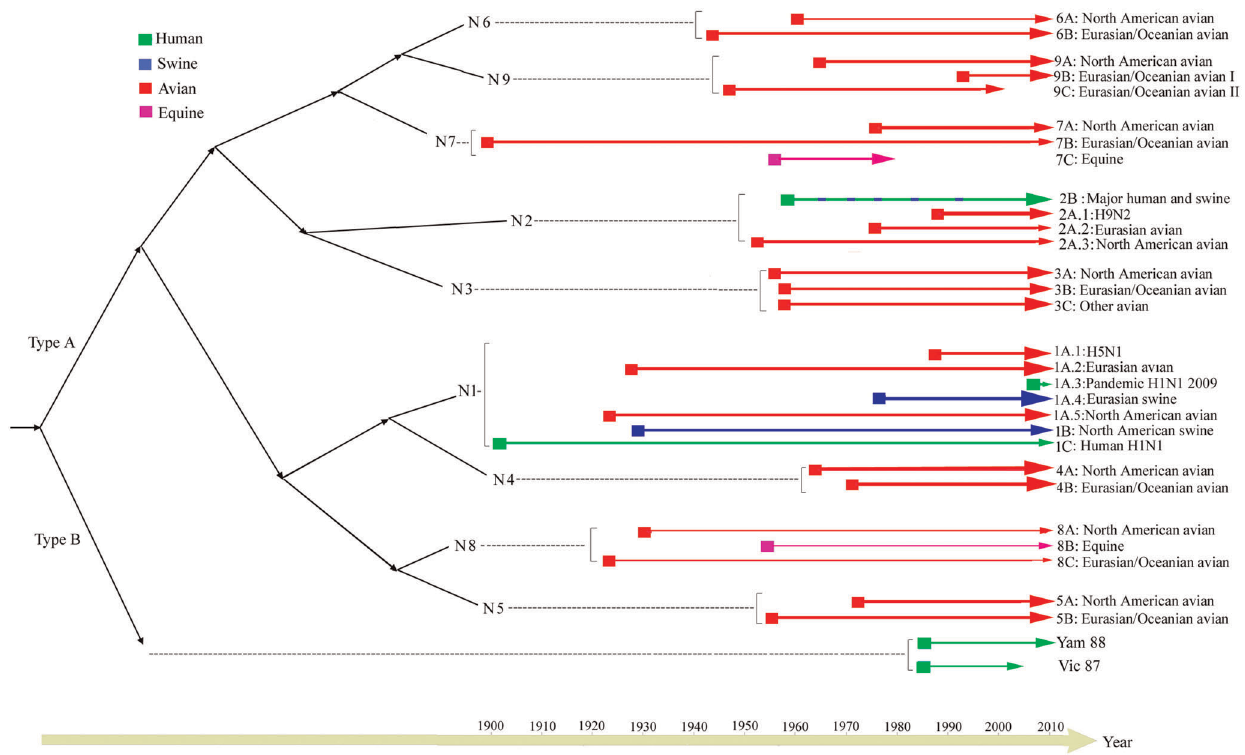
Figure 6. The evolutionary dynamics of influenza neuraminidase (NA) over time. The lineages from different hosts are colored, with the emergence times of the lineages represented by the horizontal positions of squared boxes and the mean substitution rates depicted by the degree of line thickness. Note that within 2A there are five swine clusters.